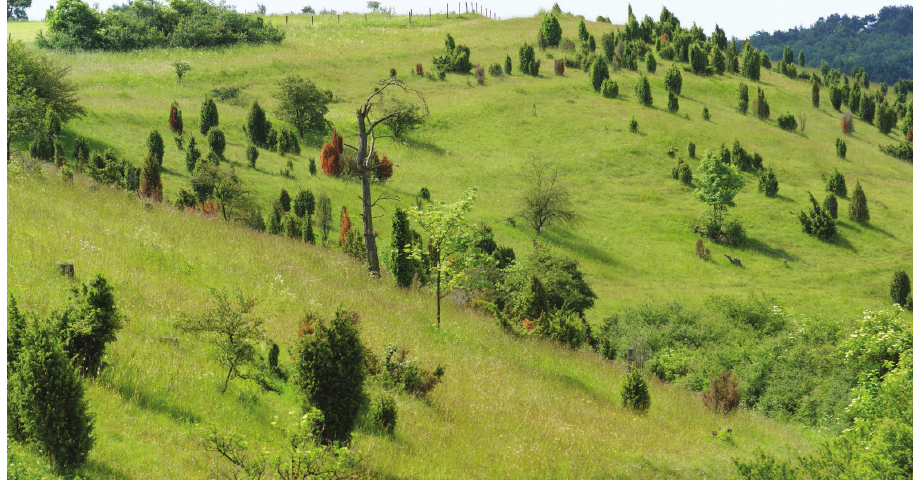
there as well. Habitats: dry calcareous grasslands and steppes (20%), dry siliceous grasslands (15%), mesophile grasslands (9%), coniferous woodland (7%), alpine and subalpine grasslands (7%), humid grasslands and tall herb communities (7%), heath and scrub (6%).